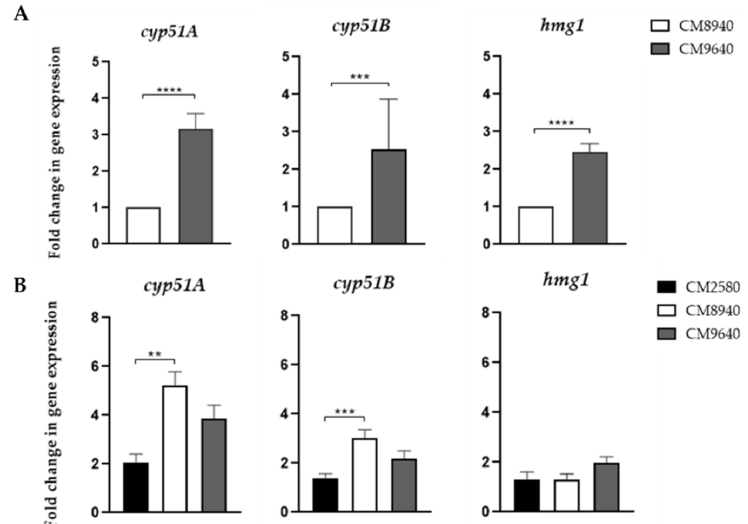
Figure 1. ( A ) Fold changes in expression of cyp51A , cyp51B and hmg1 for CM8940 and CM9640 isolates. ( B ) Fold changes in expression of cyp51A , cyp51B and hmg1 with and without VCZ induction for CM2580, CM8940 and CM9640 strains. Mann-Whitney t test was performed to statistical significance. P values under 0.01 were considered significant. ** p < 0.001, *** p < 0.0001, **** p < 0.00001.